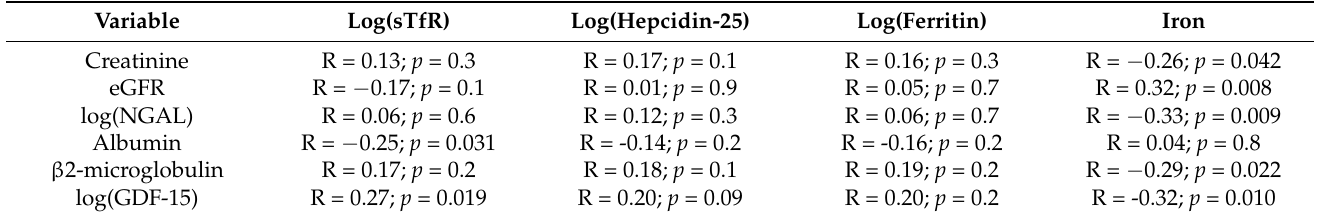
Table 4. Simple correlations of studied laboratory markers of iron metabolism with markers of renal impairment and tumor burden.